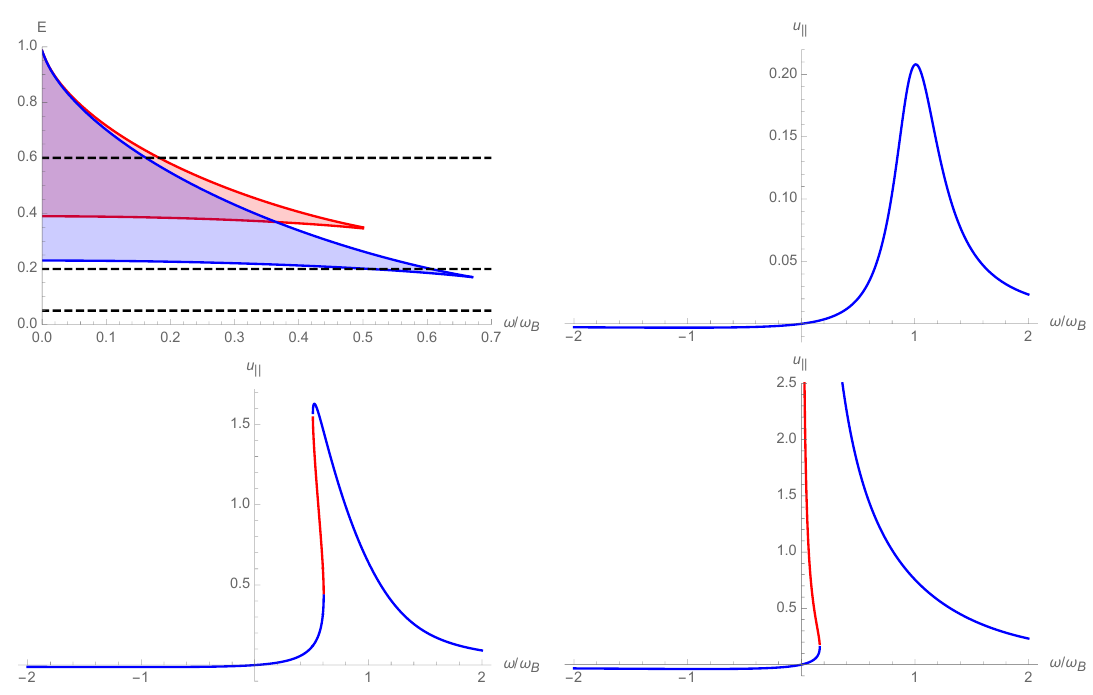
Figure 2 . Top left: the phase diagram for B = 1, (cid:26) = 1, ! B = (cid:26)B= ( (cid:15) + p ), (cid:27) Q = 0 : 25 (blue) and (cid:27) Q = 0 : 5 (red). In the shaded region there are three solutions of which two are stable; outside there is a single real solution. The dashed lines corresponds to the value of E in the other plots, ( E = 0.05 (top right), 0.2 (bottom left), and 0.6 (bottom right)). For the bottom two panels the red curve corresponds to the unstable solution.